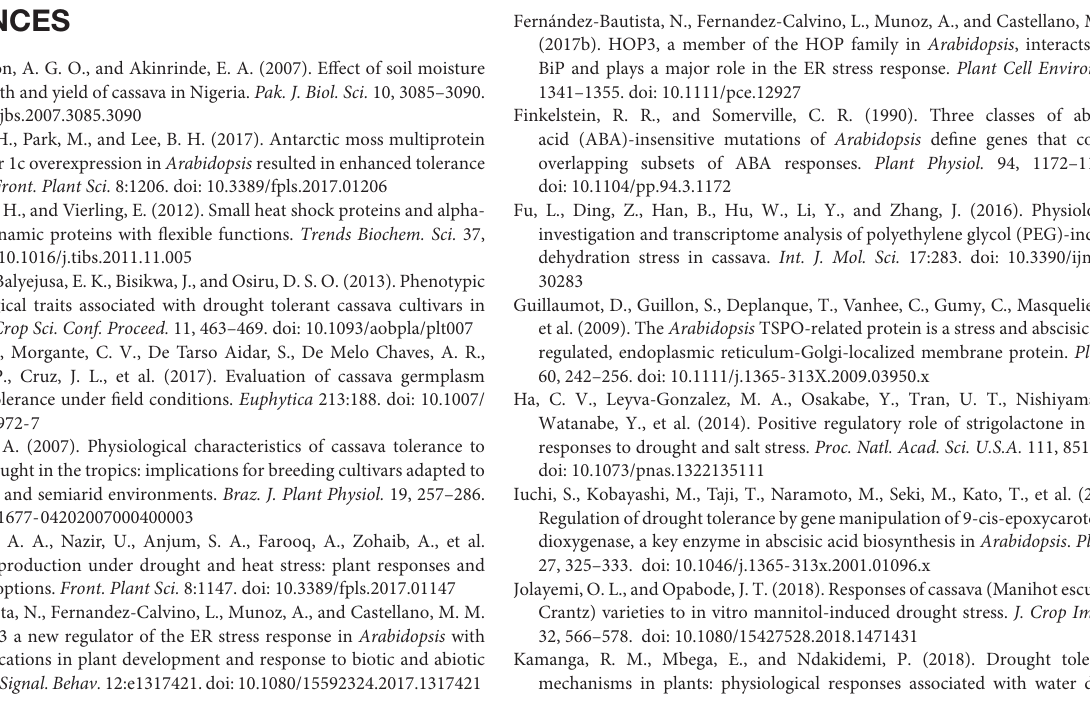
FIGURE S1 | Leaf wilting phenotype of representative water-treated (control) cassava plant after being subjected to a drought (A) , representative cassava plant not subjected to a drought (soil drying) (B,D,E) , representative cassava plant subjected to a drought stress (C) . Images in which the width of the leaflet (blue line) exceeded 10% of the midrib length (red line) were excluded from the analyzed dataset. FIGURE S2 | Phylogenetic tree of SnRK2 and NCED amino acid sequences from cassava ( Manihot esculenta , Me) and Arabidopsis ( Arabidopsis thaliana , At).